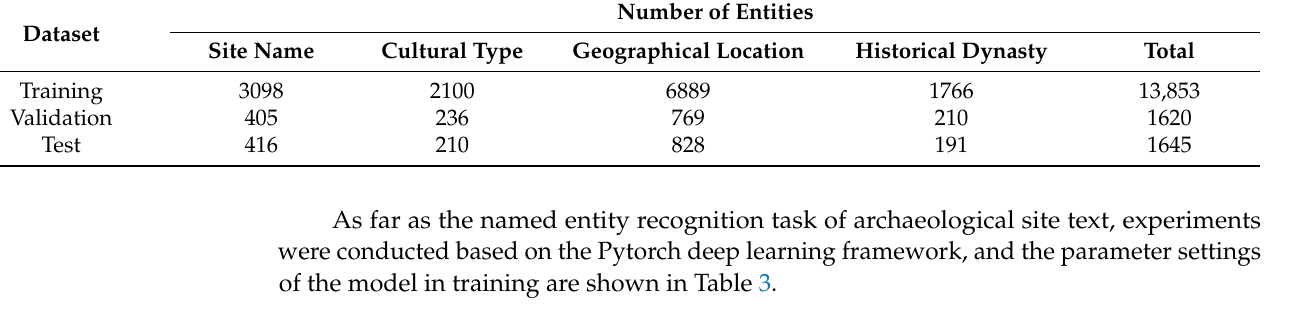
Table 3. Training parameters of the BiLSTM-CRF model.